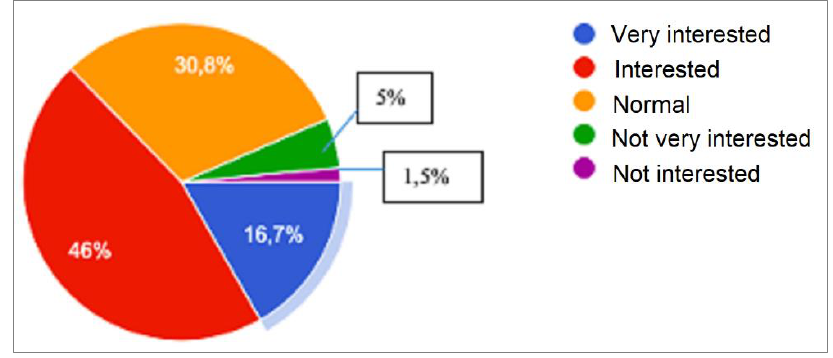
Figure 2. Teachers' interest in using idioms and proverbs in mathematics teaching